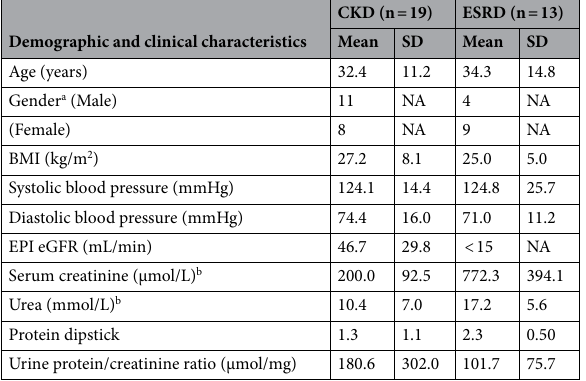
Table 1. Demographic and clinical characteristics of CKD and ESRD study groups. BMI body mass index, eGFR estimated glomerular filtration rate. a Presented as the number of subjects in each group. b Significantly different between CKD and ESRD (independent t-test, P value <